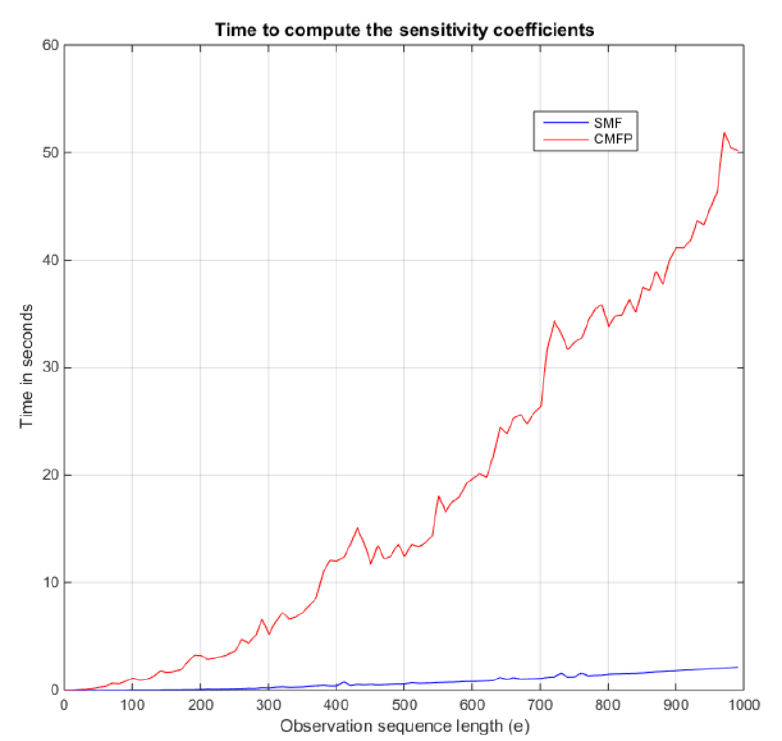
Figure 3. Time in seconds to compute the sensitivity coefficients for an observation sequence length from 1 to 1000 with a step size of